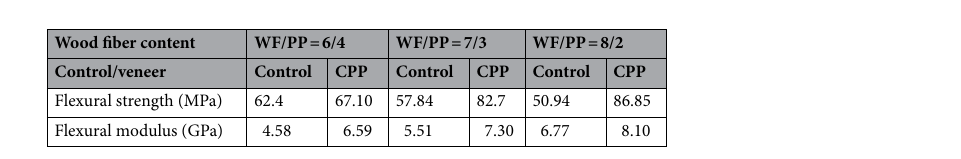
Table 5. Flexural properties of WF/PP composite